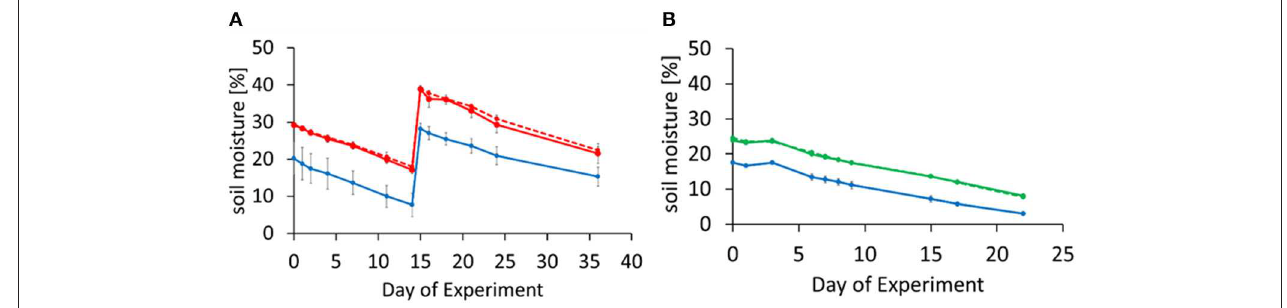
FIGURE 1 | Temporal change in volumetric soil moisture during the incubation for Experiment 1 (A) and Experiment 2 (B) . Soils were rewetted at day-0 (for all soils in both experiments) and day-14 [for oil palm and riparian reserve soils in Experiment 1 (A) ] and the moisture decreased with time. Error bars represent standard deviation of means from triplicate incubations. (A) OP2, 2 year old oil palm plantation (solid red circles, solid red line), OP7, 7 year old oil palm plantation (solid red circles, dashed red line); (B) LFE, logged forest (solid green circles, dashed green line), E, logged forest (solid green circles, solid green line); (A,B) RR, riparian reserve (solid blue circles, solid blue